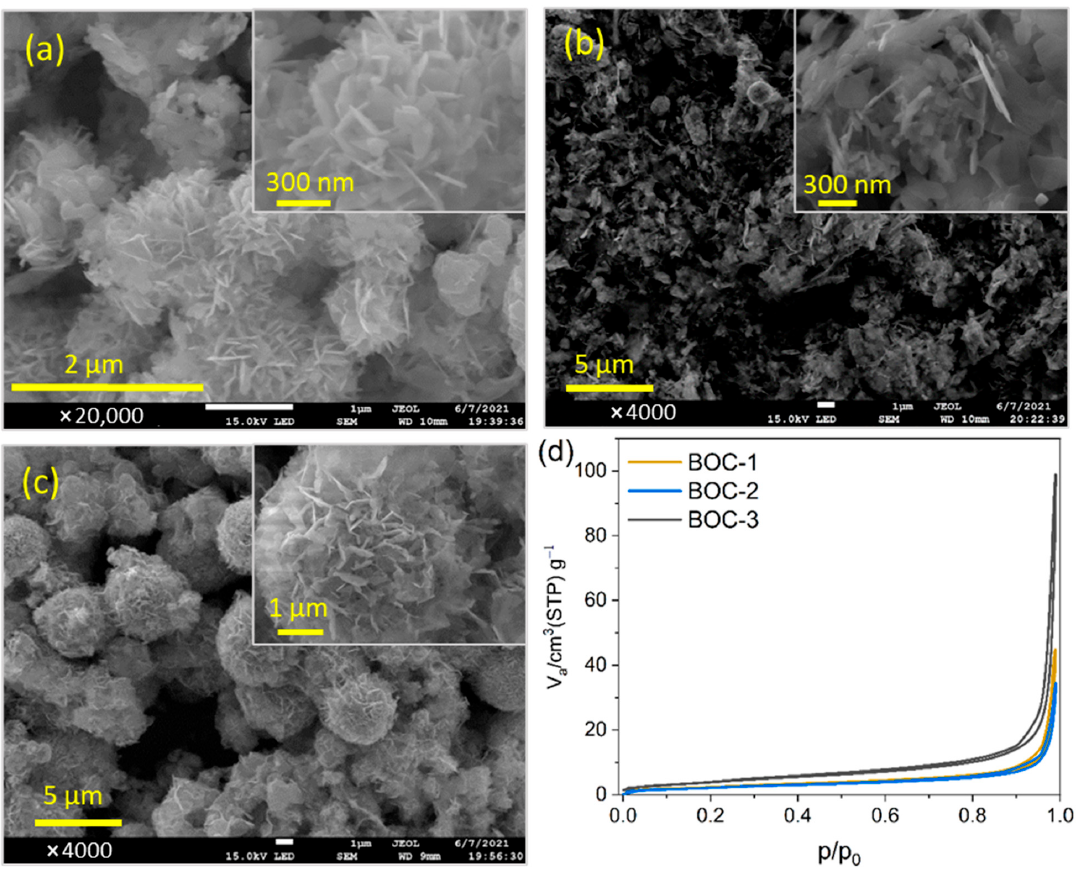
Figure 1. FESEM images of ( a ) BOC-1, ( b ) BOC-2, and ( c ) BOC-3; insets show the respective SEM image with high resolution. ( d ) N 2 adsorption–desorption isotherms of all